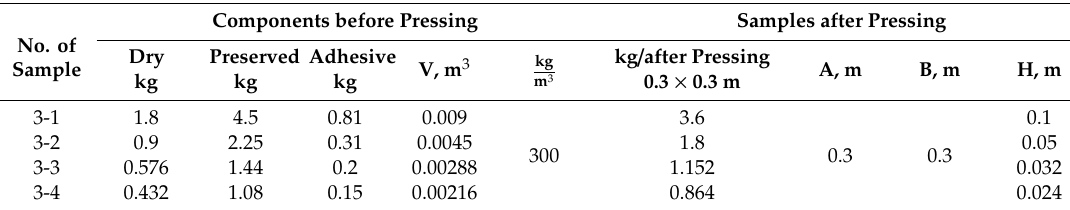
Table 3. Components of samples from the third